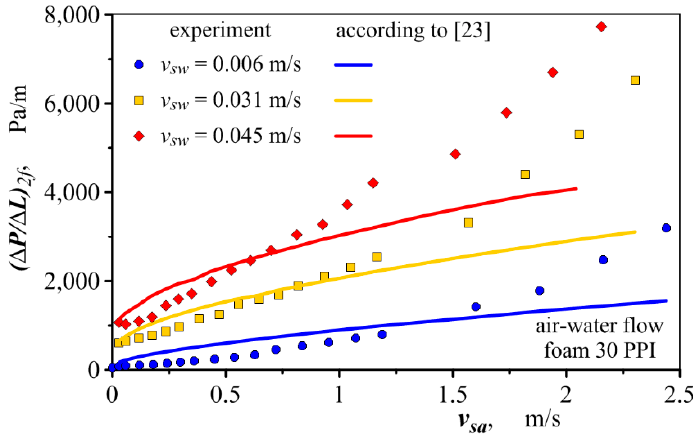
Figure 12. Comparison of changes in the pressure drop value measured and calculated with the use of the model [23] as a function of the air velocity for selected conditions of the air––water flow through a channel filled with 30 PPI foam.